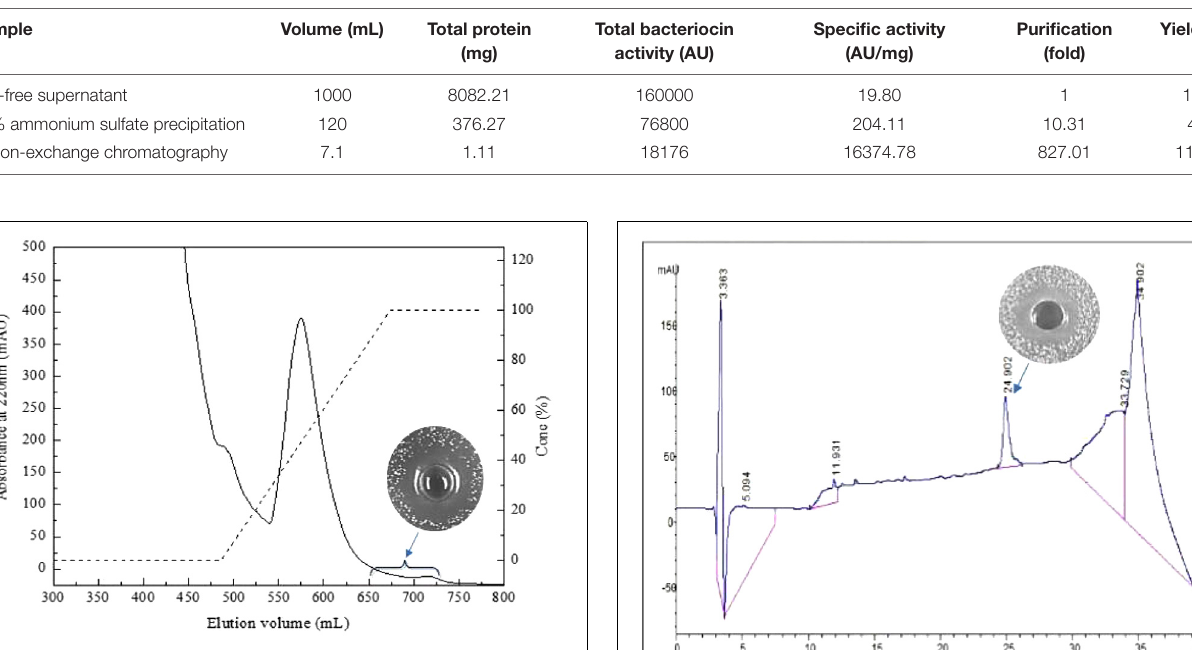
TABLE 2 | Purification of bacteriocin produced by L. plantarum B23.